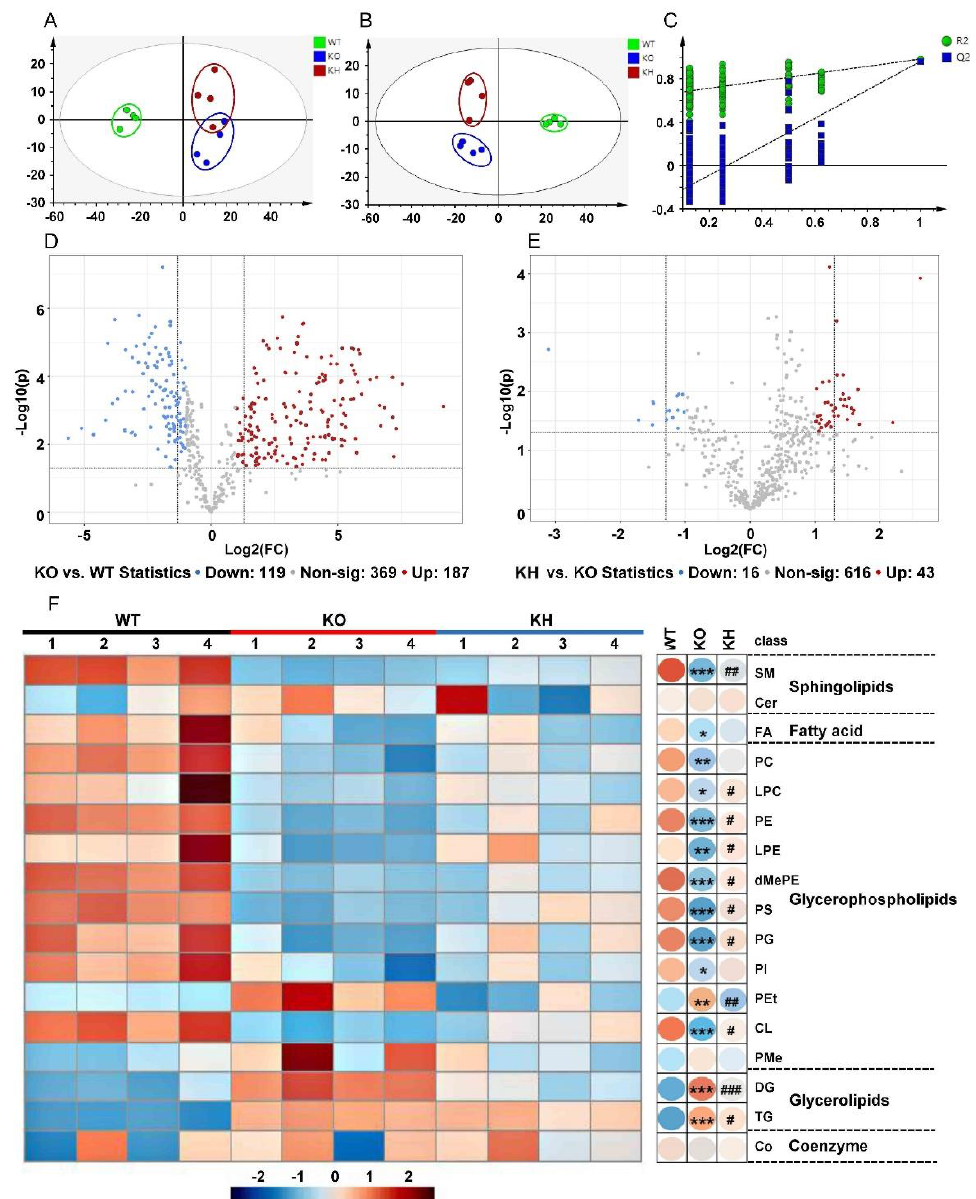
Figure 5. HTE altered lipid classes in liver of Lepr − / − rats. ( A ) PCA score plots for the hepatic lipids (R 2 X = 0.907; Q 2 = 0.518); ( B ) PLS–DA score for the hepatic lipids (R 2 X = 0.864; R 2 Y = 0.994; Q 2 = 0.905); ( C ) PLS–DA model validation (R 2 = 0.645; Q 2 = − 0.35); ( D ) Volcano plot displaying differential lipid classes between KO and WT; ( E ) Differential lipid classes between KH and KO. In the volcano plot, a number of significantly different lipid species were filtered out based on the criteria of FC ≥ 2 or ≤ 0.5 and p ≤ 0.05. Red (up) and blue (down) dots represent significant differentials of lipid species, whereas gray dots represent no significant differences of lipid species ( n = 4). ( F ) Heat map representing lipid class levels. Values that were higher and lower than the mean will be shown in red and blue boxes, respectively. * p < 0.05, ** p < 0.01, *** p < 0.001, compared to WT group; # p < 0.05, ## p < 0.01, ### p < 0.001 versus KO group ( n = 4, means ± SEM).